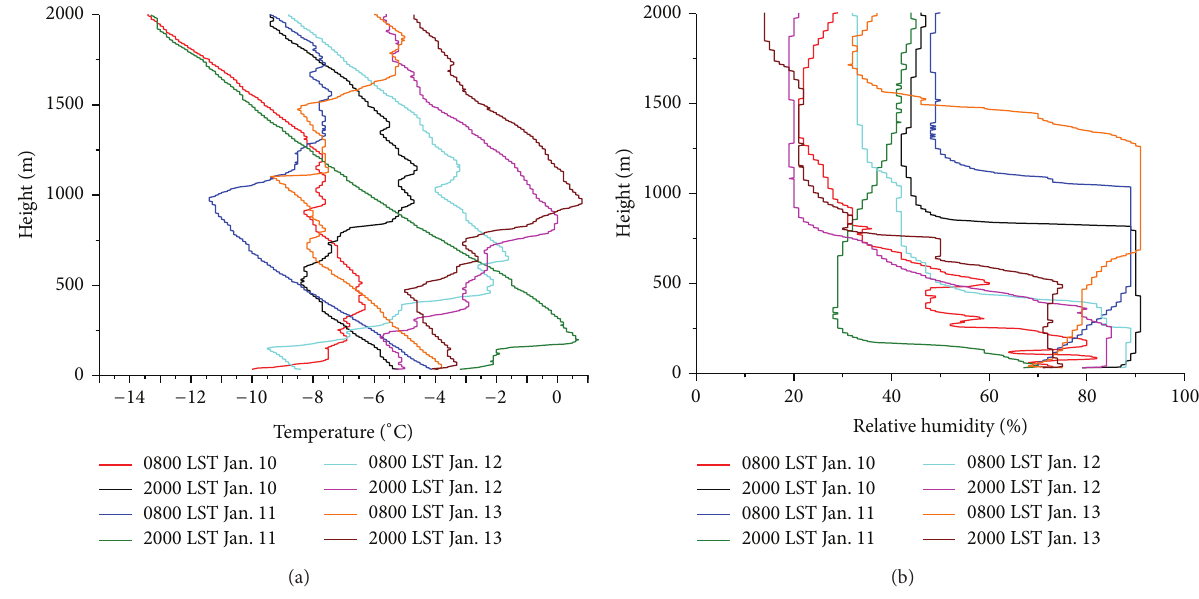
Figure 12: Profiles of temperature and humidity over different periods during 10th ∼ 13th January 2013, in